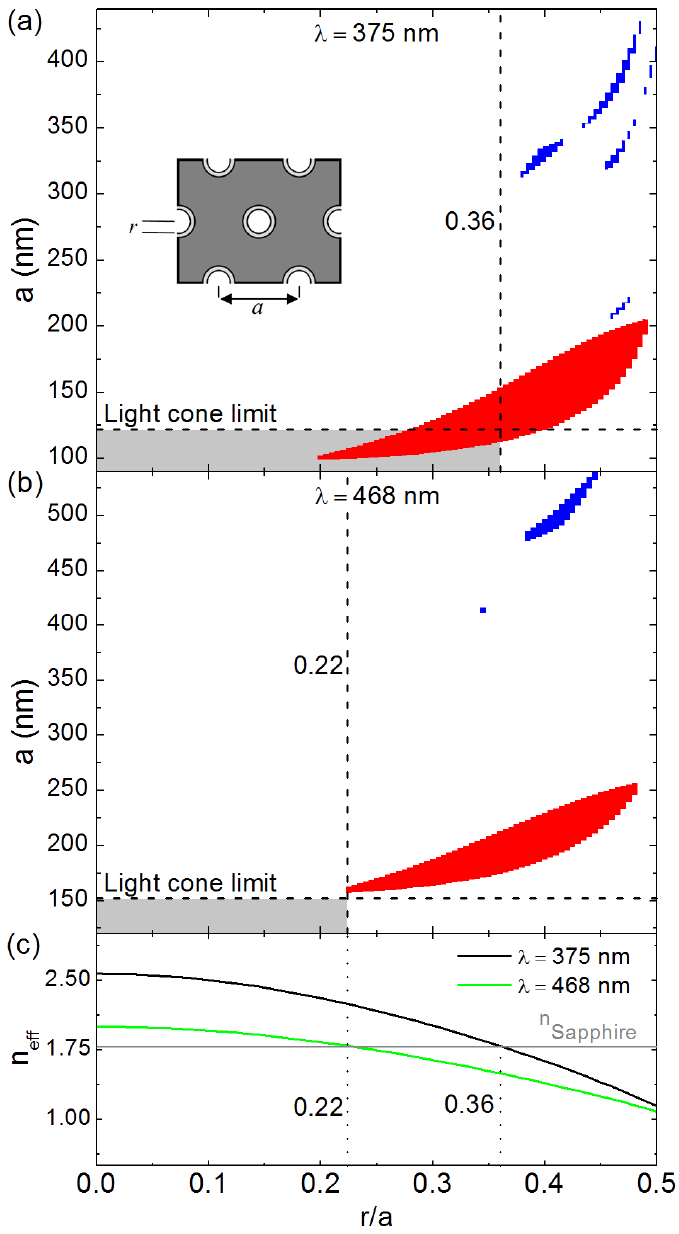
Figure 10. ( a ) Photonic band-gap map of perforated ZnO slab for λ = 375 nm; ( b ) Photonic band-gap map of perforated ZnO slab for λ = 468 nm; ( c ) Effective refractive index of the perforated ZnO slab obtained by Maxwell-Garnett approximation for λ = 375 nm and 468